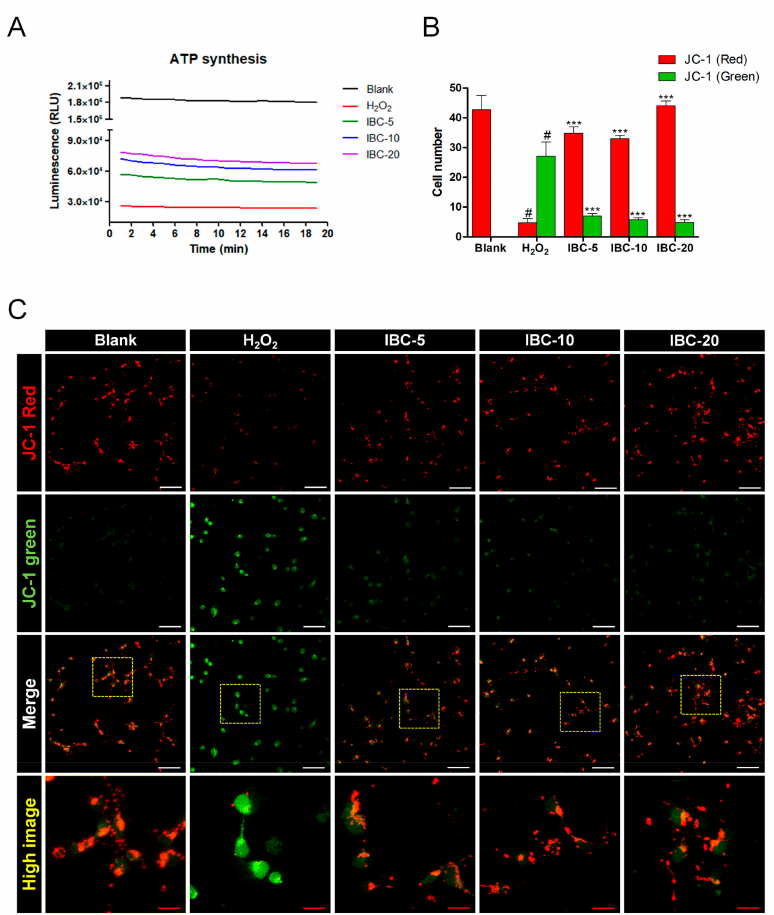
Figure 5. Effect of IBC extract on mitochondrial function following H 2 O 2 -induced oxidative stress injury in rat primary cortical neurons. ( A ) Quantifying cellular ATP level in the mitochondria. ( B , C ) Quantitative analysis ( B ) and representative images (n = 4) ( C ) of JC-1-stained mitochondria for assessing mitochondrial membrane potential ( ∆Ψ m). White scale bar = 50 µ m, Red scale bar = 15 µ m. Data are expressed as the means ± SEM. Significant differences indicated as # p < 0.001 compared vs. the blank group, *** p < 0.001 vs. the H 2 O 2 group were analyzed via one-way ANOVA with Tukey’s post hoc